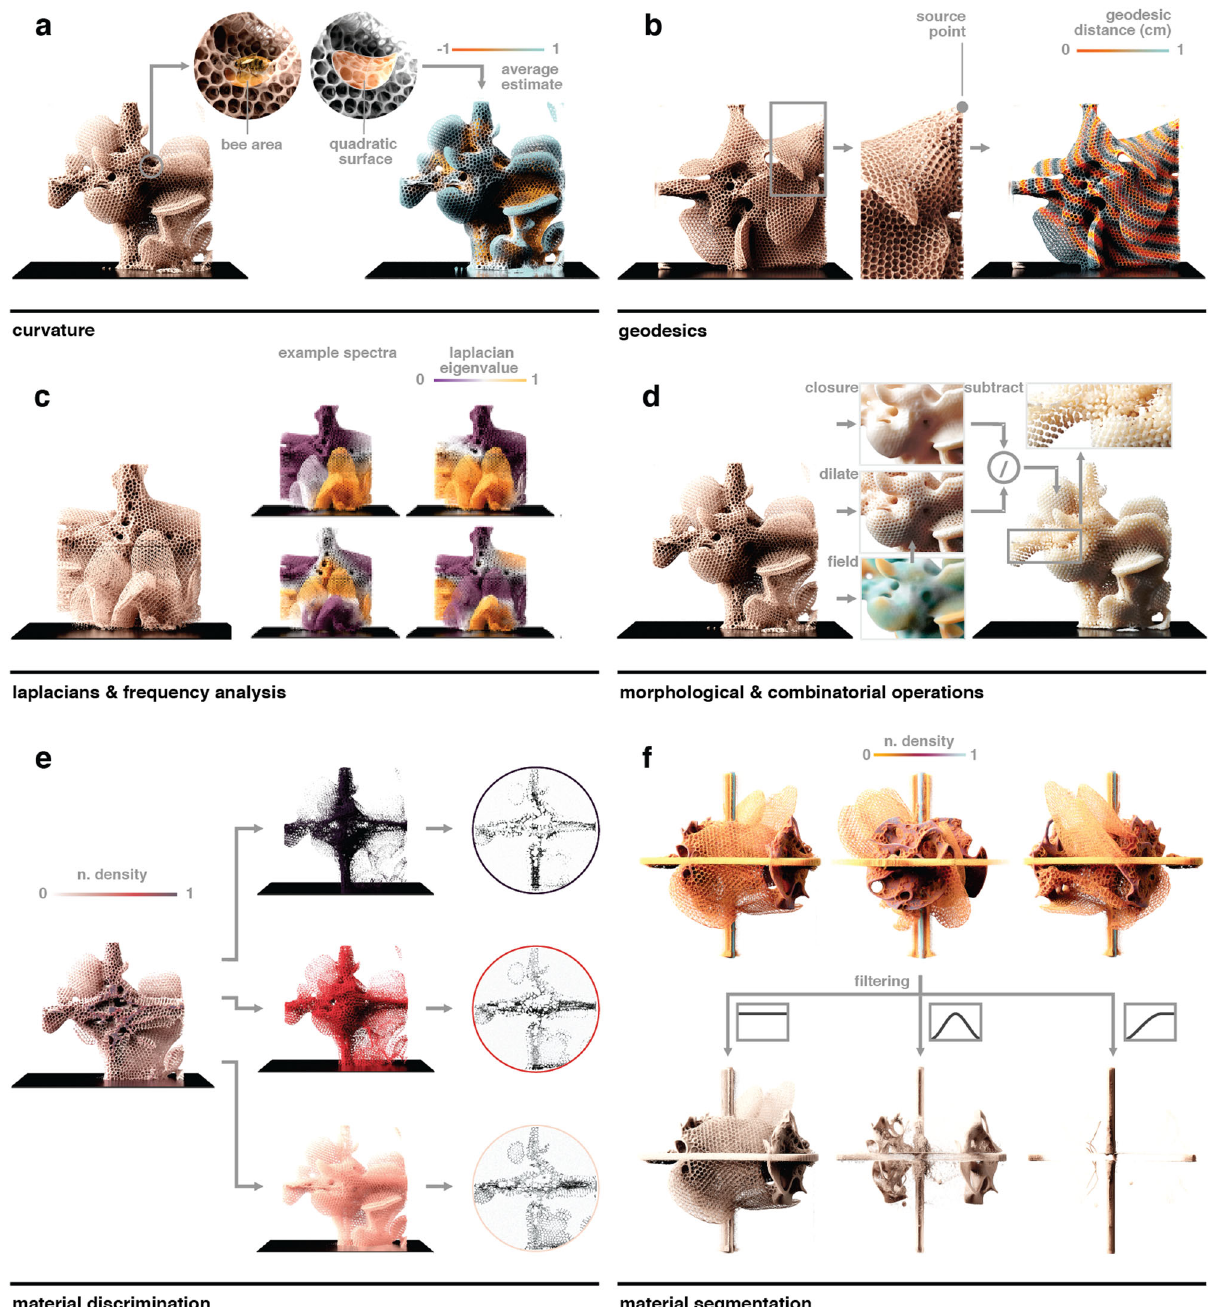
Fig. 3 Primary computational geometry tools used to analyze comb architectures. a To compute a Gaussian curvature estimation across a digital comb topography, at every point of the comb structure, a radius ( r = 15 mm) corresponding to the size of an A. mellifera worker was used to sample neighboring positions to which a quadratic surface was fi tted. The quadratic form was then used to compute the curvature analytically. b To plot a geodesic distance from a source point, the geodesic distance was computed on the surface of the shown comb structure, and 1-cm periods were plotted to show equidistant propagation from the selected point. c Different harmonic bases of the Laplace operator are shown with color values denoting the per-vertex amplitudes. Together with the eigenvalues of the Laplace operator, these are commonly employed as shape descriptors. d Morphological operations of dilation and closing were used in combination with combinatorial operators, such as subtraction and intersection, to extract cells and tunnels from comb architectures. e Normalized attenuation contrast values from X-ray data were used to discriminate different materials within the combs; i.e., bee-deposited wax, manually applied wax foundation, and 3D-printed polymer or acrylic support structures. f Thus, substructures of different density ranges could be selectively fi ltered for and visualized in the digital environment. A. mellifera constructed combs are displayed yellow, 3D-printed parts are shown in magenta (density = 1.19 g/ cm³), and steel rods are displayed in cyan.